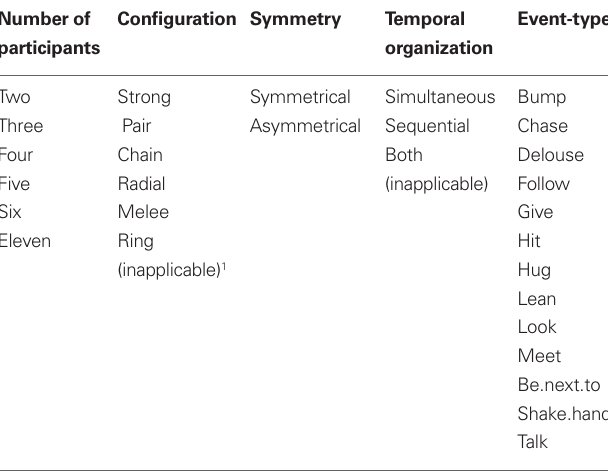
Table 1 | Parameters varied in reciprocal videoclips.